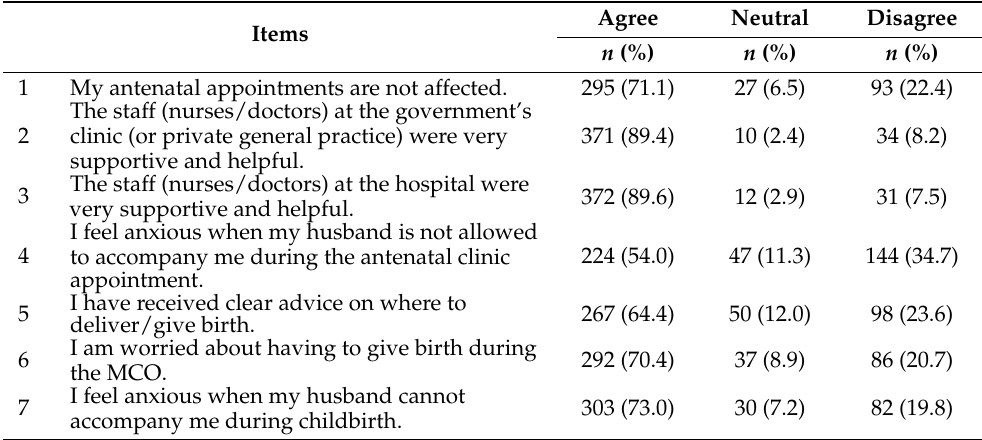
Table 4. Maternal experience during COVID-19